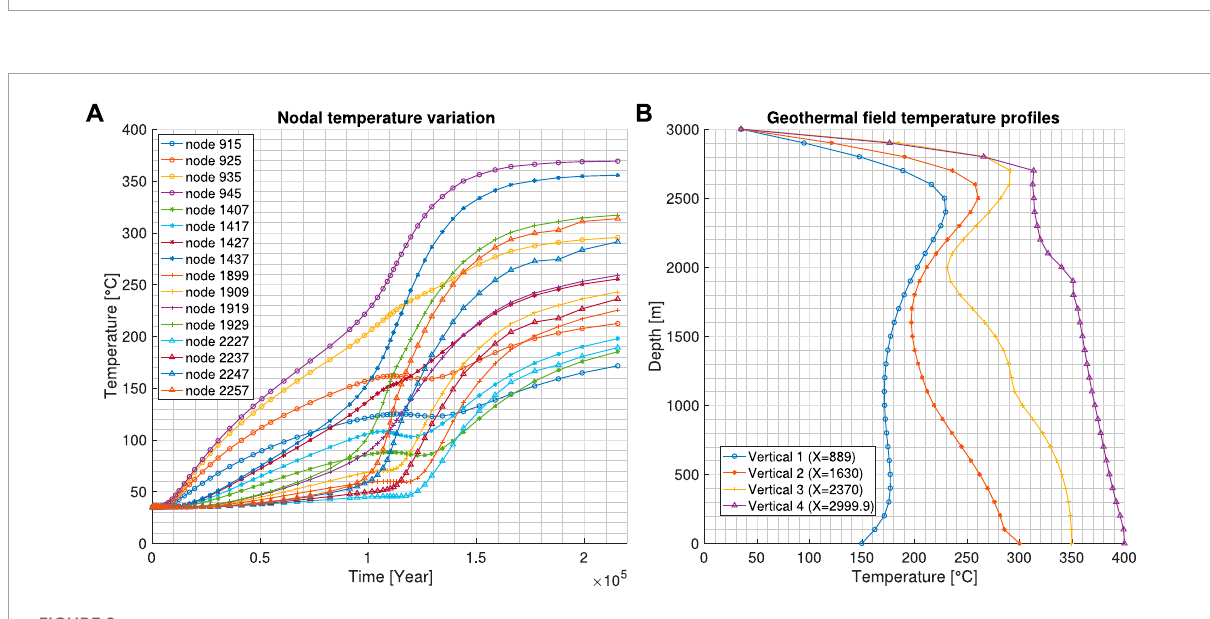
FIGURE 8 Nodal temperature variation with the time (A) and geothermal field temperature profiles ( t fin ) (B)